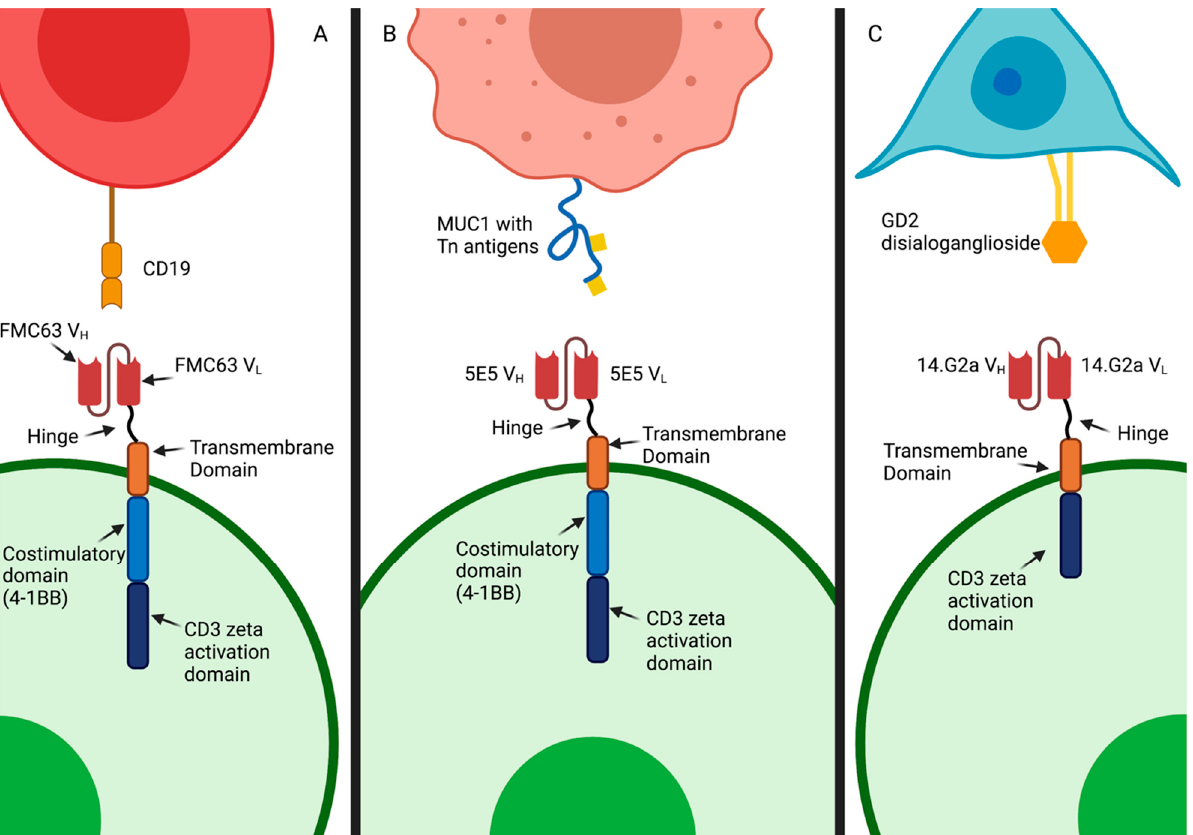
Figure 1. Schematic representation of exemplary CAR T-cell interactions with antigenic targets made of amino acids, such as FMC63-based anti-CD19 CAR T-cells targeting CD19+ B-cells ( A ), 5E5-based anti-Tn-MUC1 CAR T-cells targeting the glycoepitope Tn-MUC1 on a solid tumor cell ( B ), and 14G2a-based anti-GD2 CAR T-cells targeting the ganglioside GD2 on a neuroblastoma cell ( C ).